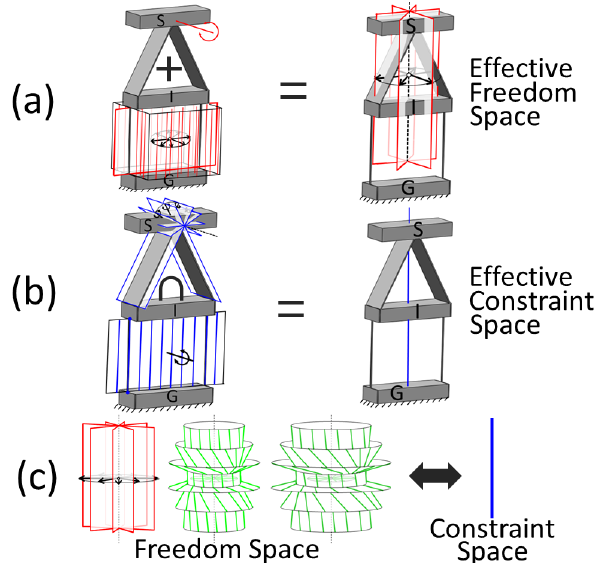
Figure 8. Linearly combine freedom spaces in series (a) or find the intersection of their constraint spaces (b) to find the system’s complementary freedom and constraint spaces (c)